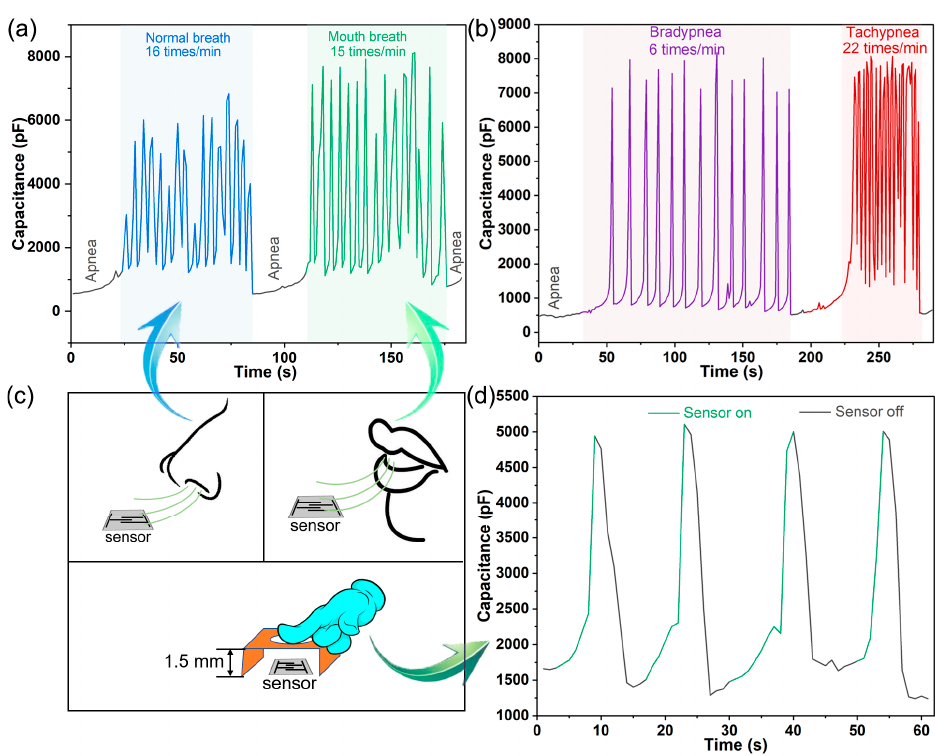
Figure 10. Application to respiratory and non-contact detection. ( a ) Monitoring of normal breath, breath-holding, and mouth breath; ( b ) monitoring of bradypnea and tachypnea; ( c ) schematic diagram of human respiration pattern and non-contact measurement style; ( d ) the curve of non-contact skin humidity sensing performance.